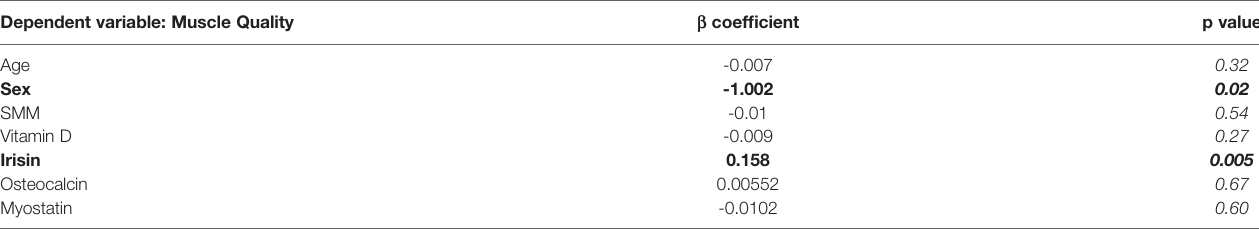
TABLE 3 | Multivariate linear regression model to investigate the determinants of muscle quality; b and p values as indicated. Dependent variable: Muscle Quality